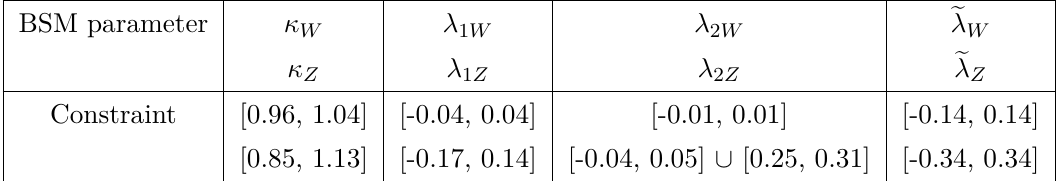
Table 4 . Projected constraints on BSM parameters with 1000 fb − 1 integrated luminosity at 95%